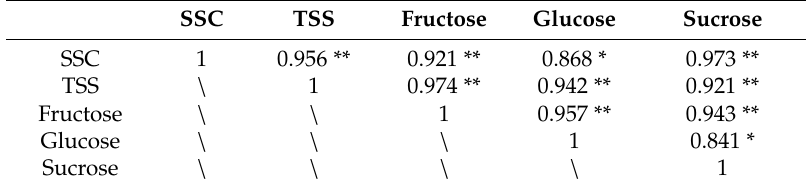
Table 1. Pearson (cid:48) s linear correlation coe ffi cients among SSC and soluble sugars for 50 days at 25 ◦ C.